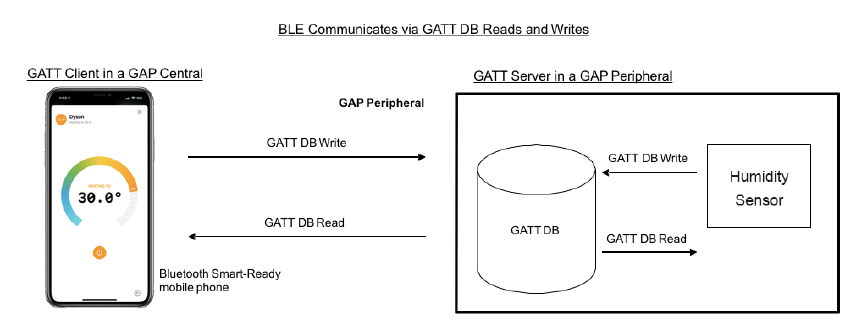
Figure 3. BLE Communicates via GATT DB, where GATT server is the humidity sensor and GATT client is the mobile